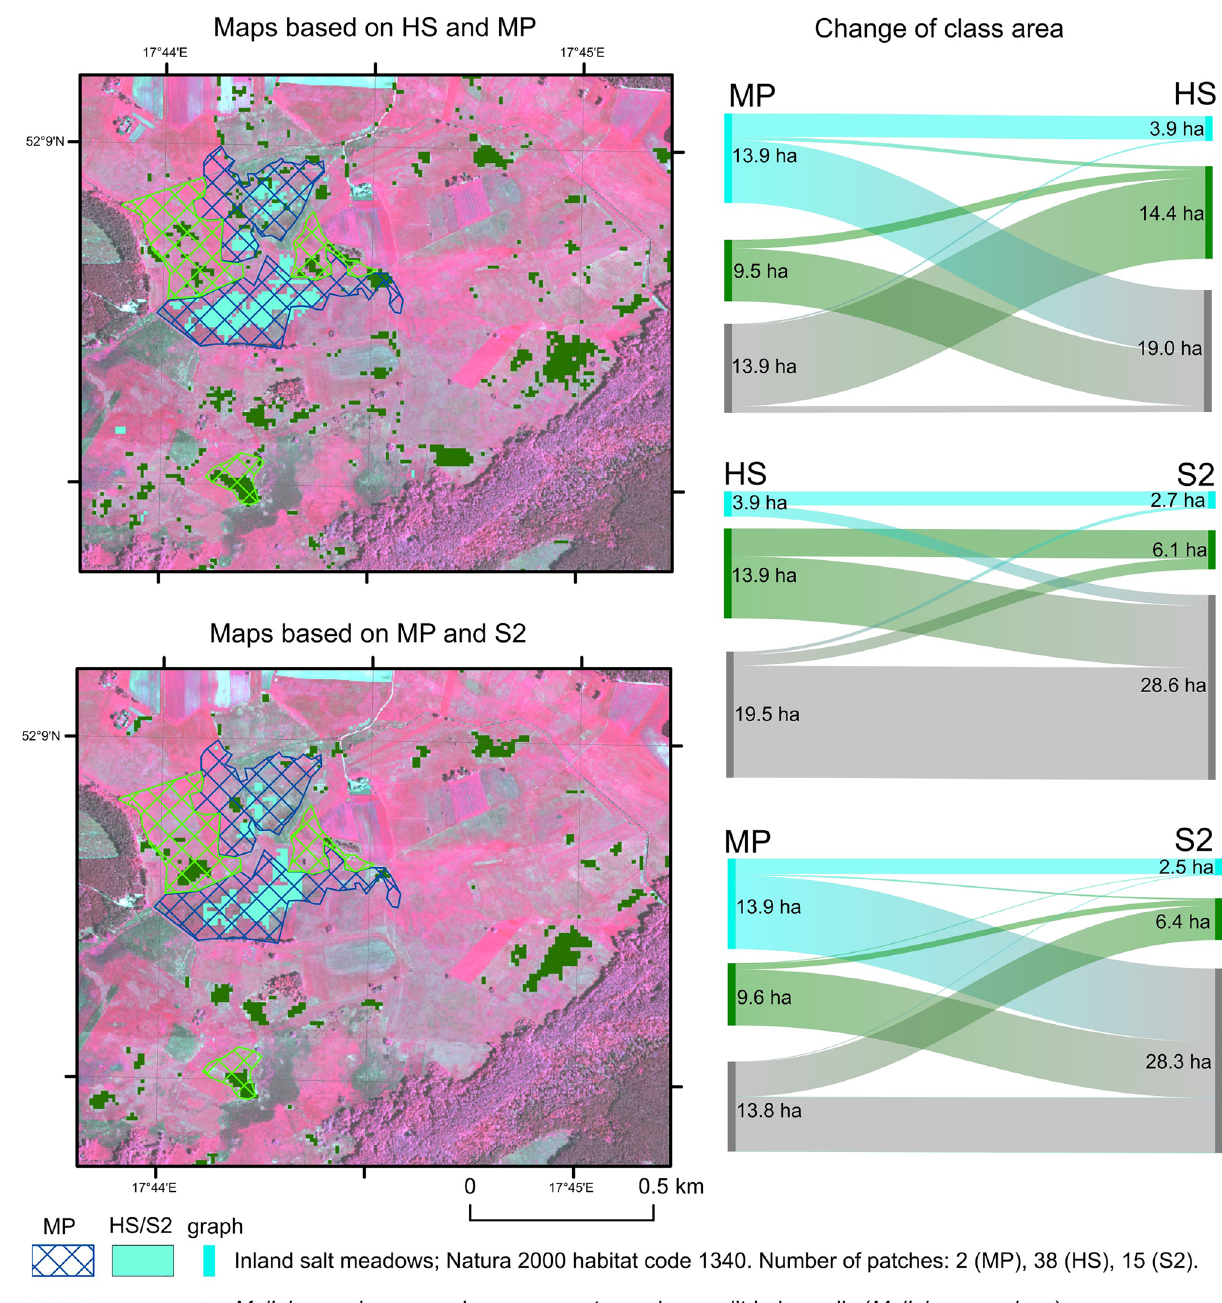
Figure 8. The classification results in the NA1 area based on HS and S2 images compared with MP maps. On the left are presented Sankey graphs showing the area difference for each map. The aerial photos used in the map background are CIR-composition quick look taken from HySpex data acquired for this study as part of the HabitARS project. Figure created by the authors using ArcMap 10.6.1 software (https:// suppo rt. esri. com/ en/ Produ cts/ Deskt op/ arcgis- deskt op/ arcmap) and SankeyMATIC (https:// sanke ymatic. For habitat 6410, the differences in the maps are even greater. Of the 9.53 ha of habitat patches present on the MP maps, only 1.33 ha were confirmed using the HS data and 0.90 using the S2 data. At the same time, classifica- tion of HS data indicates the presence of 13.11 ha of habitat patches (HS data classification) and 5.54 ha for S2 results in places outside the habitat range on the MP data. The concordance of the MP maps with HS, calculated as a percentage of confirmed habitat area with MP on the HS map, can thus be estimated at 21.11%, while the MP maps against S2 are estimated at 13.98%.